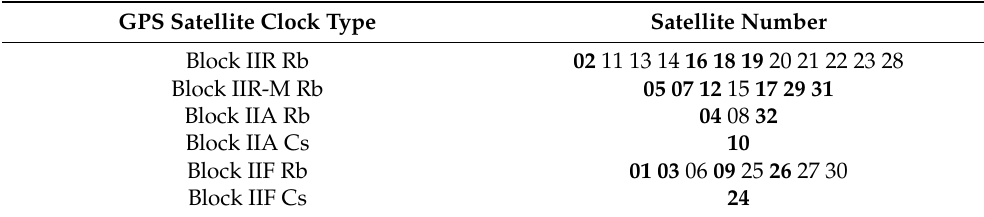
Table 2. Types of GPS satellite clock during the data collection period (Bold indicates selected satellites. GPS represents Global Positioning System, Rb and Cs represent Rubidium and Cesium, respectively).